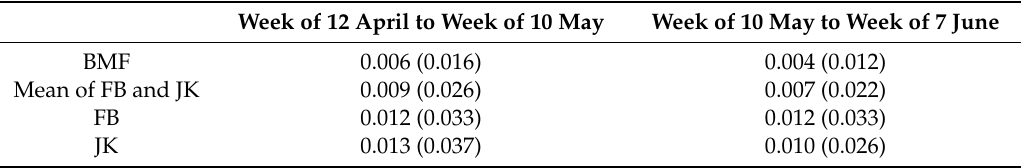
Figure 1. Frequency distributions of BCS scores for the mean of both manual assessors ( A ) and the BMF ( B ). Bland–Altman plots for manual assessors’ agreement with a lower confidence limit of − 43, a mean di ff erence of − 0.11, and an upper confidence limit of 0.2 ( C ) and the mean of the assessor’s agreement with BMF with a lower confidence limit of − 0.3, a mean di ff erence of 0 (due to the scale conversion), and an upper confidence limit of 0.3 ( D ). Table 3. Within subject standard deviation (95% reproducibility limit) as per calculations described in McAlinden et al [20] ( n =